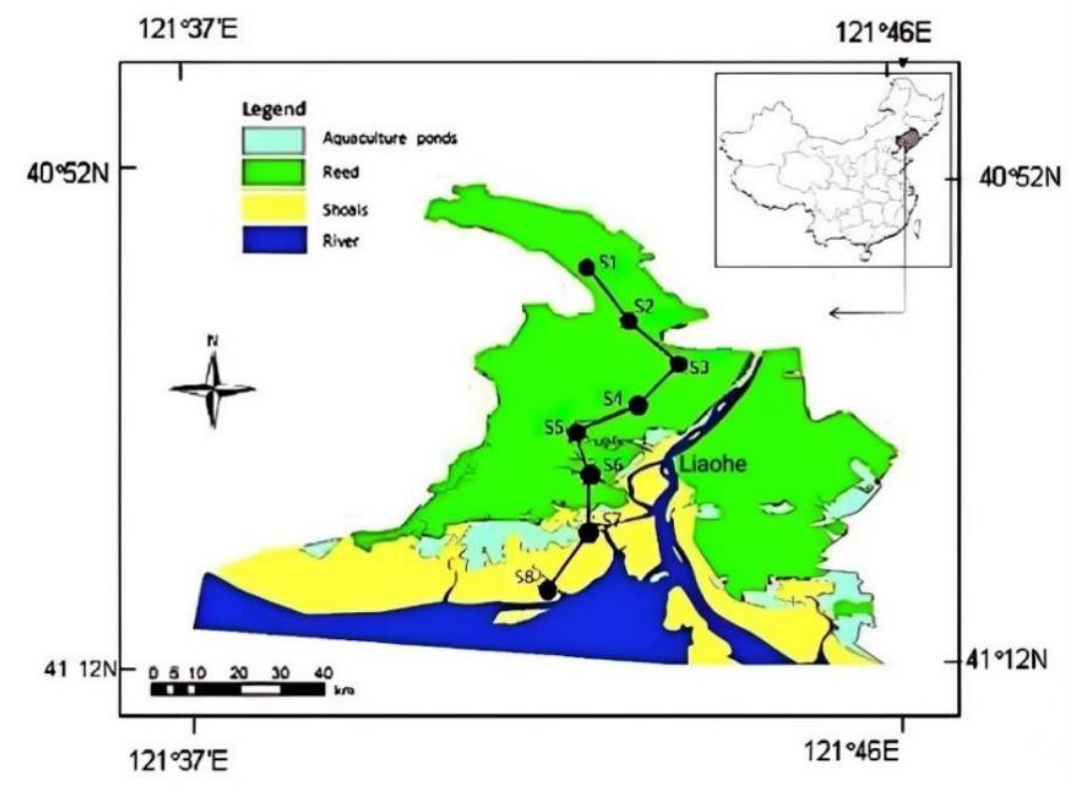
Figure 1. Study area and sampling site.